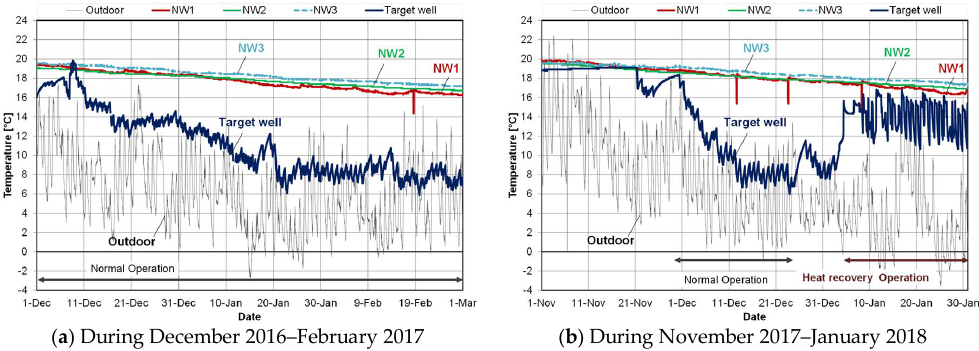
Figure 4. Well-water temperature changes along with the neighborhood well-water temperatures.